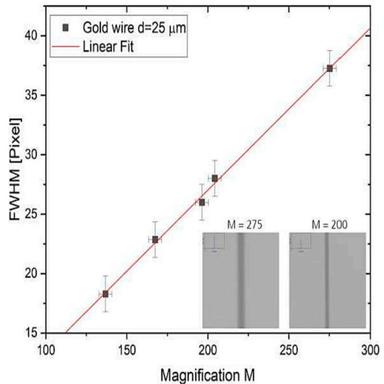
Dependence of full width at half maximum (FWHM) as a function of magnification (M) for a 25 μm thick gold wire, fitted with a linear relationship.